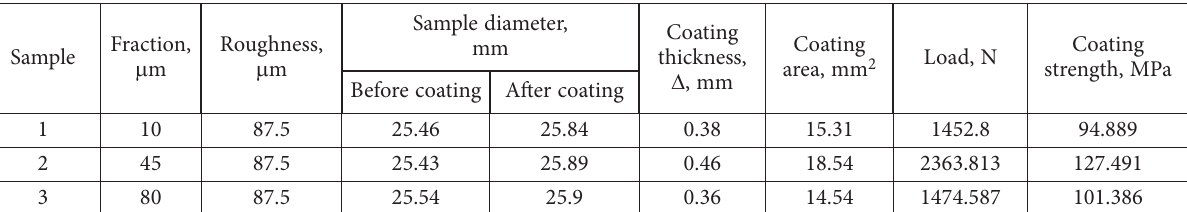
Table 1. Al 2 O 3 coatings’ strength